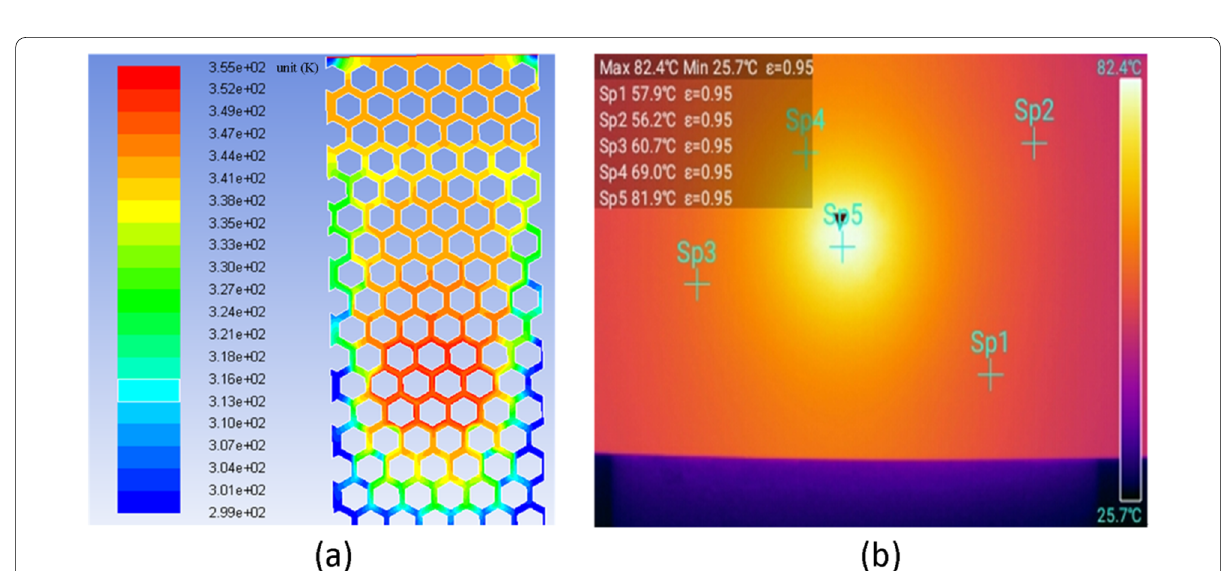
Figure 13 Temperature contour of the micro-channel heat sink from a FE simulation and b